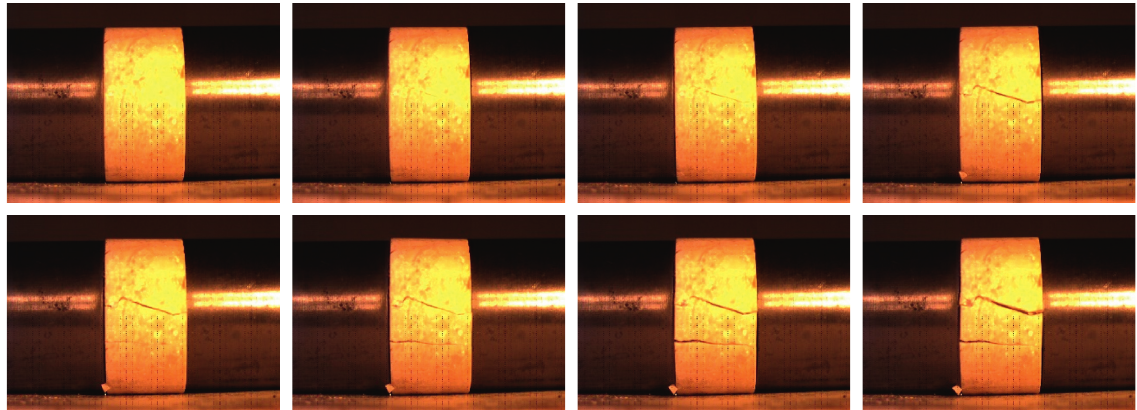
Figure 6: Failure process under the impact compression loading.